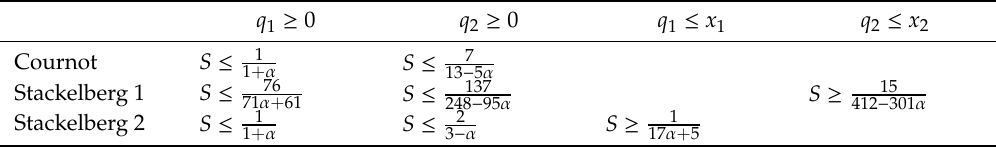
Table A1. Technical conditions for interior solutions in the three